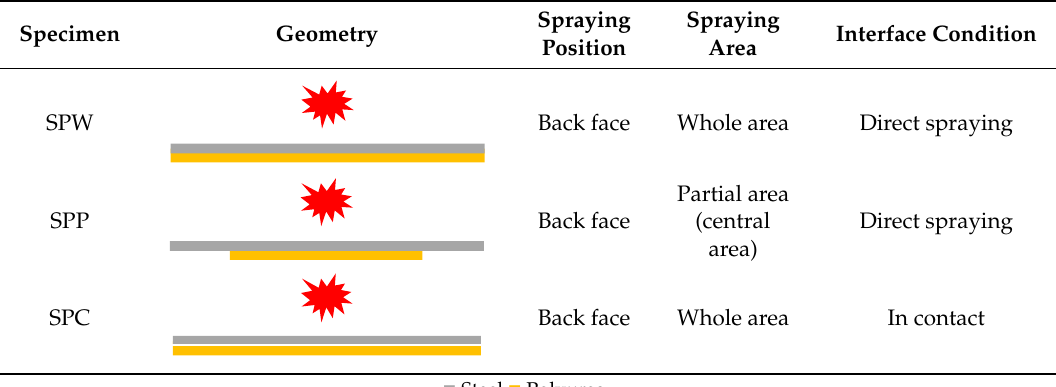
Figure 3. Quasi ‐ static true stress–strain curves of ( a ) 304 stainless steel and ( b ) LINE XS ‐ 350 specimens. Table 2. Schematic design of the three types of polyurea ‐ coated steel plates with different spraying strategies. Legend: SPW, polyurea which is sprayed on the whole area of the back side of the steel plate; SPP, polyurea (central area) of the back side of the steel plate. SPC denotes polyurea in which the polyurea backing which is sprayed onto a partial area (central area) of the back side of the steel plate; SPC, polyurea in which the Table 2. Schematic design of the three types of polyurea ‐ coated steel plates with different spraying strategies. polyurea backing layer is in contact with the rear surface of the steel layer is in contact with the rear surface of the steel plate. For comparison, bare steel plates were used Legend: SPW, polyurea which is sprayed on the whole area of the back side of the steel plate; SPP, polyurea and denoted BS. which is sprayed onto a partial area (central area) of the back side of the steel plate; SPC, polyurea in which the Table 2. Schematic design of the three types of polyurea ‐ coated steel plates with different spraying strategies. polyurea backing layer is in contact with the rear surface of the steel plate. Table 2. Schematic design of the three types of polyurea-coated steel plates with di ff erent spraying Legend: SPW, polyurea which is sprayed on the whole area of the back side of the steel plate; SPP, polyurea strategies. Legend: SPW, polyurea which is sprayed on the whole area of the back side of the steel which is sprayed onto a partial area (central area) of the back side of the steel plate; SPC, polyurea in which the plate; SPP, polyurea which is sprayed onto a partial area (central area) of the back side of the steel plate; polyurea backing layer is in contact with the rear surface of the steel plate. SPC, polyurea in which the polyurea backing layer is in contact with the rear surface of the steel plate. Table 2. Schematic design of the three types of polyurea ‐ coated steel plates with different spraying strategies. Specimen Legend: SPW, polyurea which is sprayed on the whole area of the back side of the steel plate; SPP, polyurea which is sprayed onto a partial area (central area) of the back side of the steel plate; SPC, polyurea in which the polyurea backing layer is in contact with the rear surface of the steel plate.